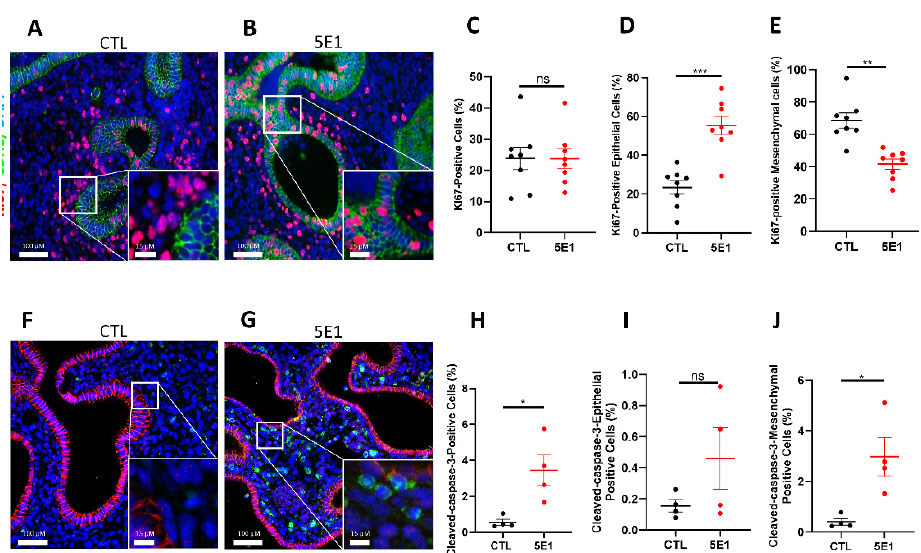
Figure 3. Hedgehog pathway inhibition alters cell proliferation and cell death in human fetal lung explants. ( A – D ) IF staining of human fetal lung explants treated with 5E1 for 48 h ( B ) or untreated ( A ) using KI67 (red) and CDH1 (as epithelial marker in green) to assess cell proliferation. Quantification of total cell proliferation ( C ), epithelial proliferation ( D ), and mesenchymal proliferation ( E ). Results are shown as mean ± SEM, n = 8 for each group. ( F , G ) Cleaved-caspase-3 IF staining of human fetal lungs treated ( G ) or not ( F ) with 5E1 to assess cell death (G vs. F; n = 4), Cleaved-caspase-3 is in green; and CDH1 in red. Quantification of total number of Cleaved-caspase-3+ cells ( H ), Cleaved-caspase3+ cells in the epithelium ( I ), and Cleaved-caspase-3+ cells in the mesenchyme ( J ). Results are shown mean ± SEM. * p < 0.05; ** p < 0.01 and *** p < 0.001; ns = no